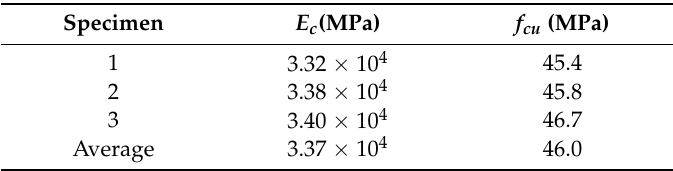
Table 1. Material properties of concrete.